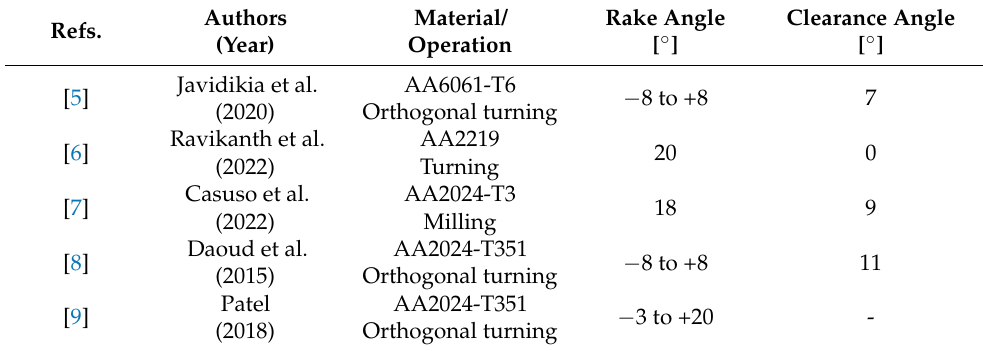
Table 1. Typical tool geometries used for machining aluminum alloys. Refs.